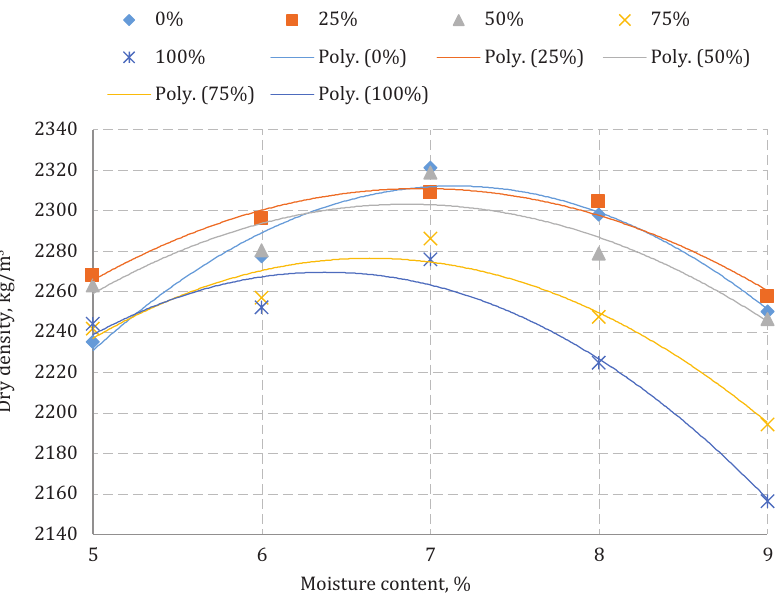
Figure 2. Optimum moisture curve of each